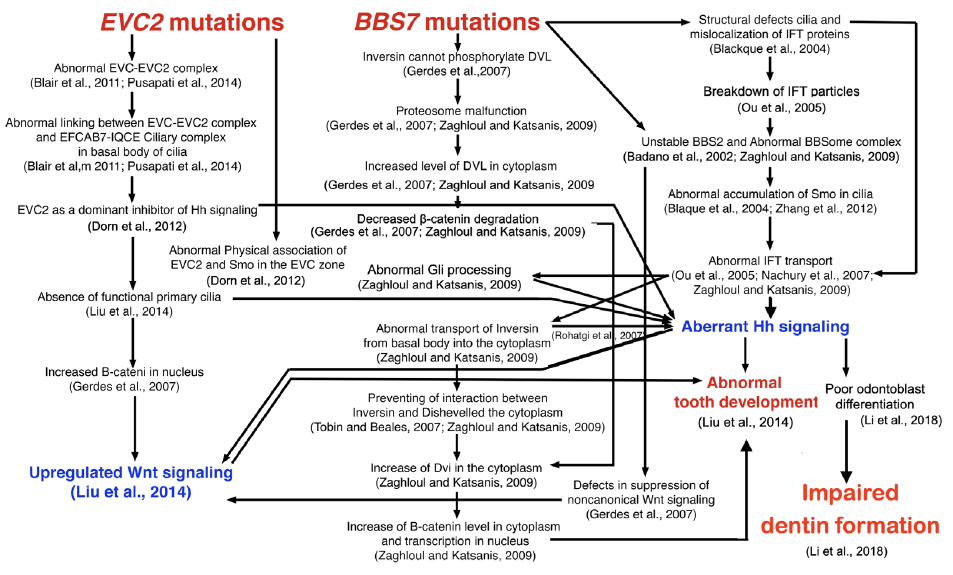
Figure 5. Flowchart shows that EVC2 , BBS2 , and BBS7 mutations resulted in an abnormal BBSome complex, disrupted intraflagellar transport, showed abnormal cilia biogenesis and function, im- paired Hh and Wnt signaling, and subsequent dental anomalies including hypodontia, microdontia, taurodontism, and impaired dentin formation [16,18,20,21,25–30,38,41–43].